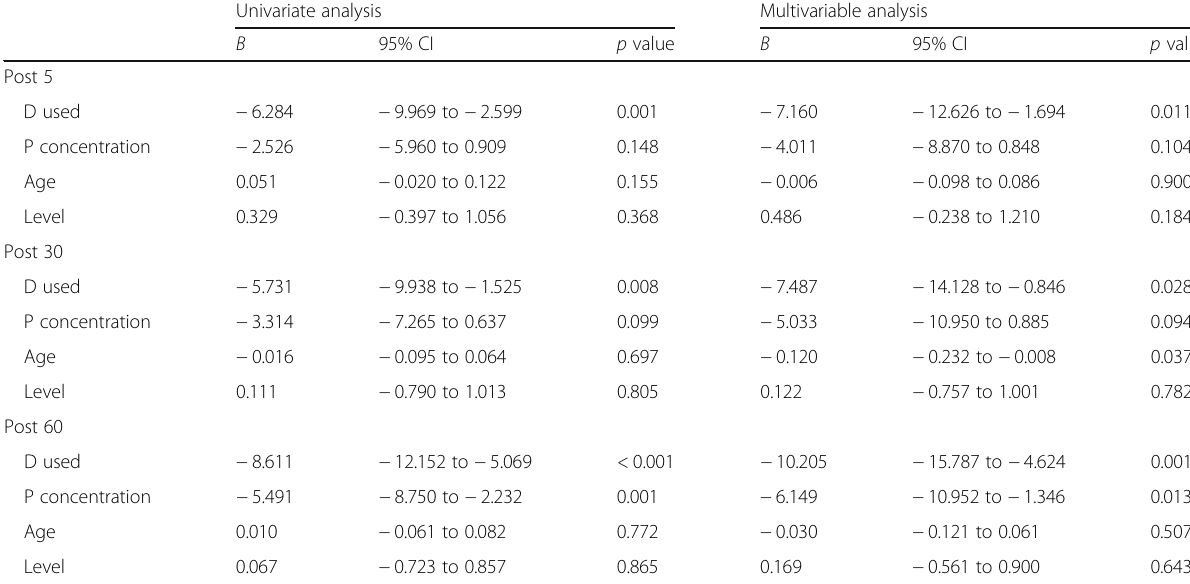
Table 2 Univariate and multivariable analyses of heart rate Univariate analysis Multivariable